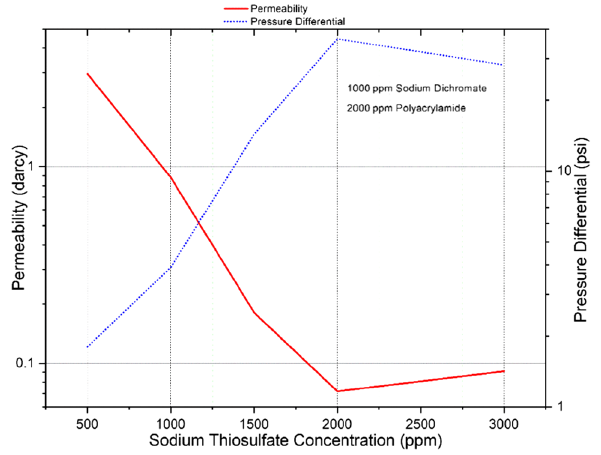
Fig. 5 Pressure drop and relative permeability behavior vs. Sodium thiosulfate concentration